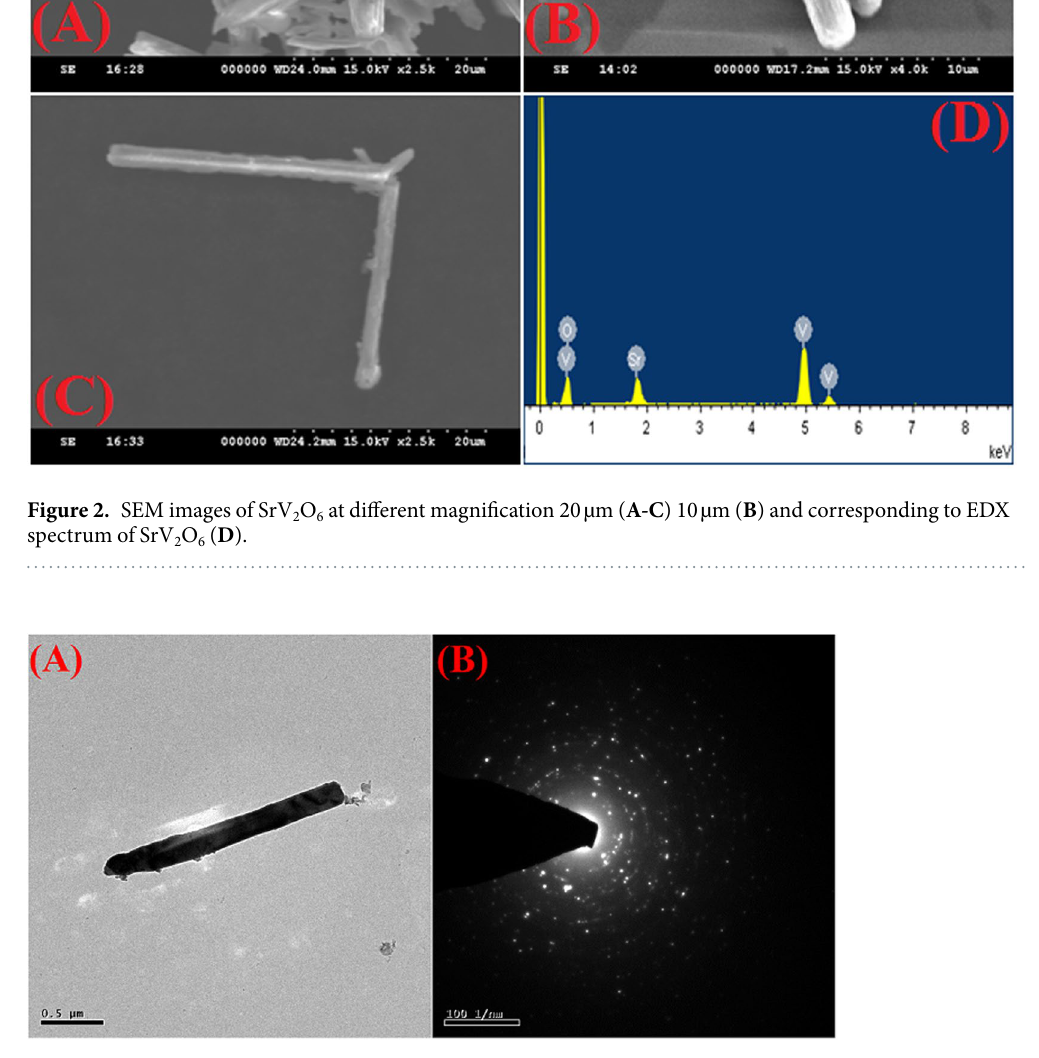
Figure 3. TEM image of SrV 2 O 6 ( A ) and SAED spectrum of SrV 2 O 6 ( B